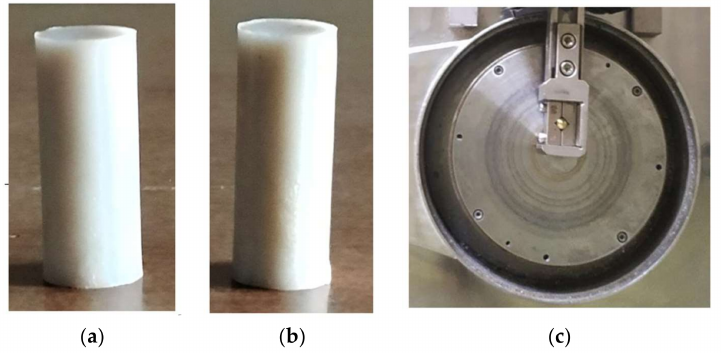
Figure 1. ( a ) GFRPA66 30 wt.% pin, ( b ) GFRPA66 35 wt.% pin, and ( c ) EN31 steel